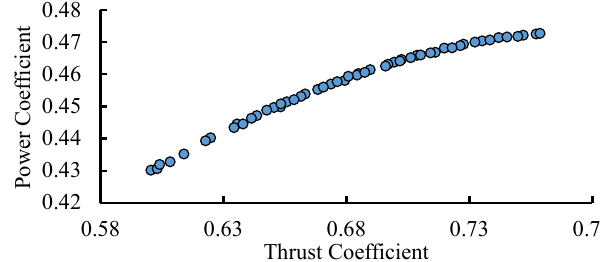
ffi cients for blade design Figure 1. Power and thrust coefficients for blade design candidates. Figure 1. Power and thrust coe